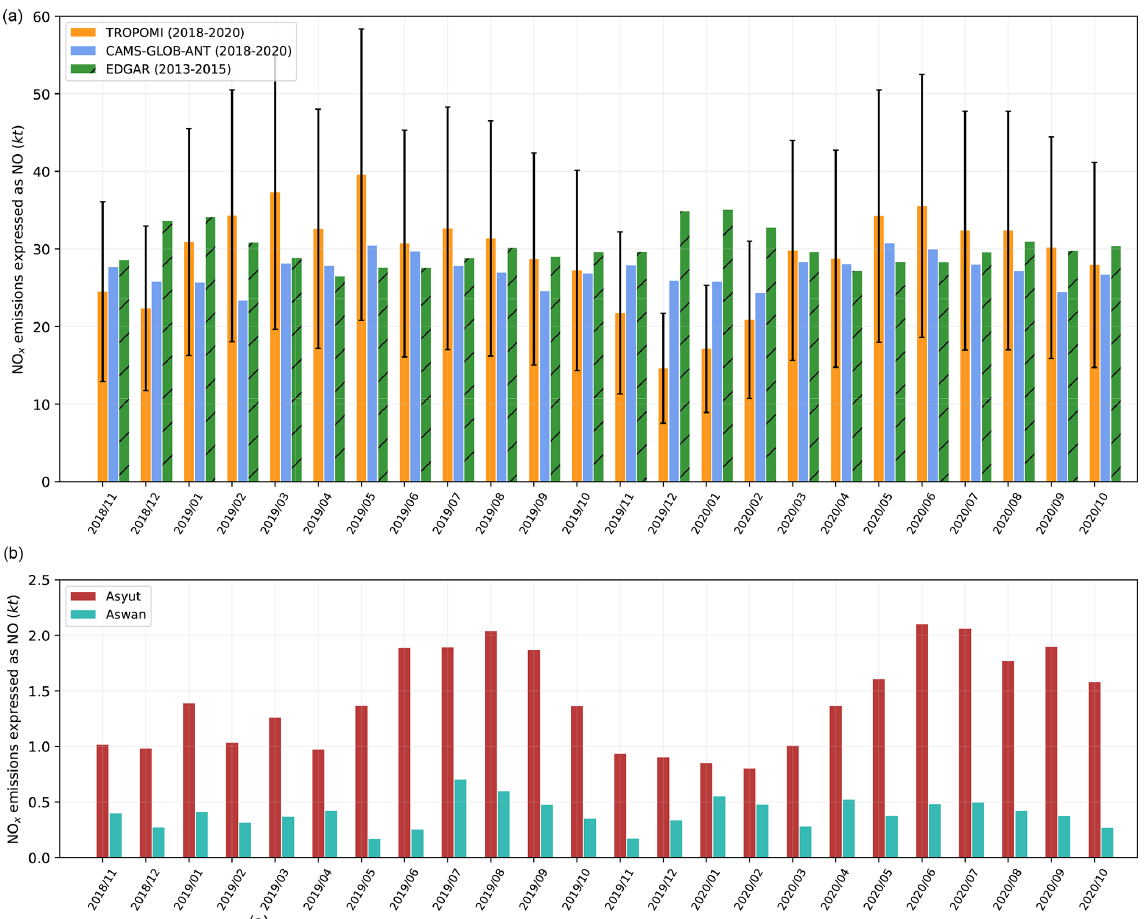
Figure 9. (a) Comparison of TROPOMI-derived anthropogenic NO x emissions in Egypt (light blue), with the corresponding emissions from EDGAR (green with stripes) and CAMS (yellow) inventories. EDGAR data are shown for comparison purposes and cover the years 2013– 2015. (b) TROPOMI-derived anthropogenic NO x emissions for the cities of Asyut (dark red) and Aswan (light blue). The corresponding domains are displayed in Fig.